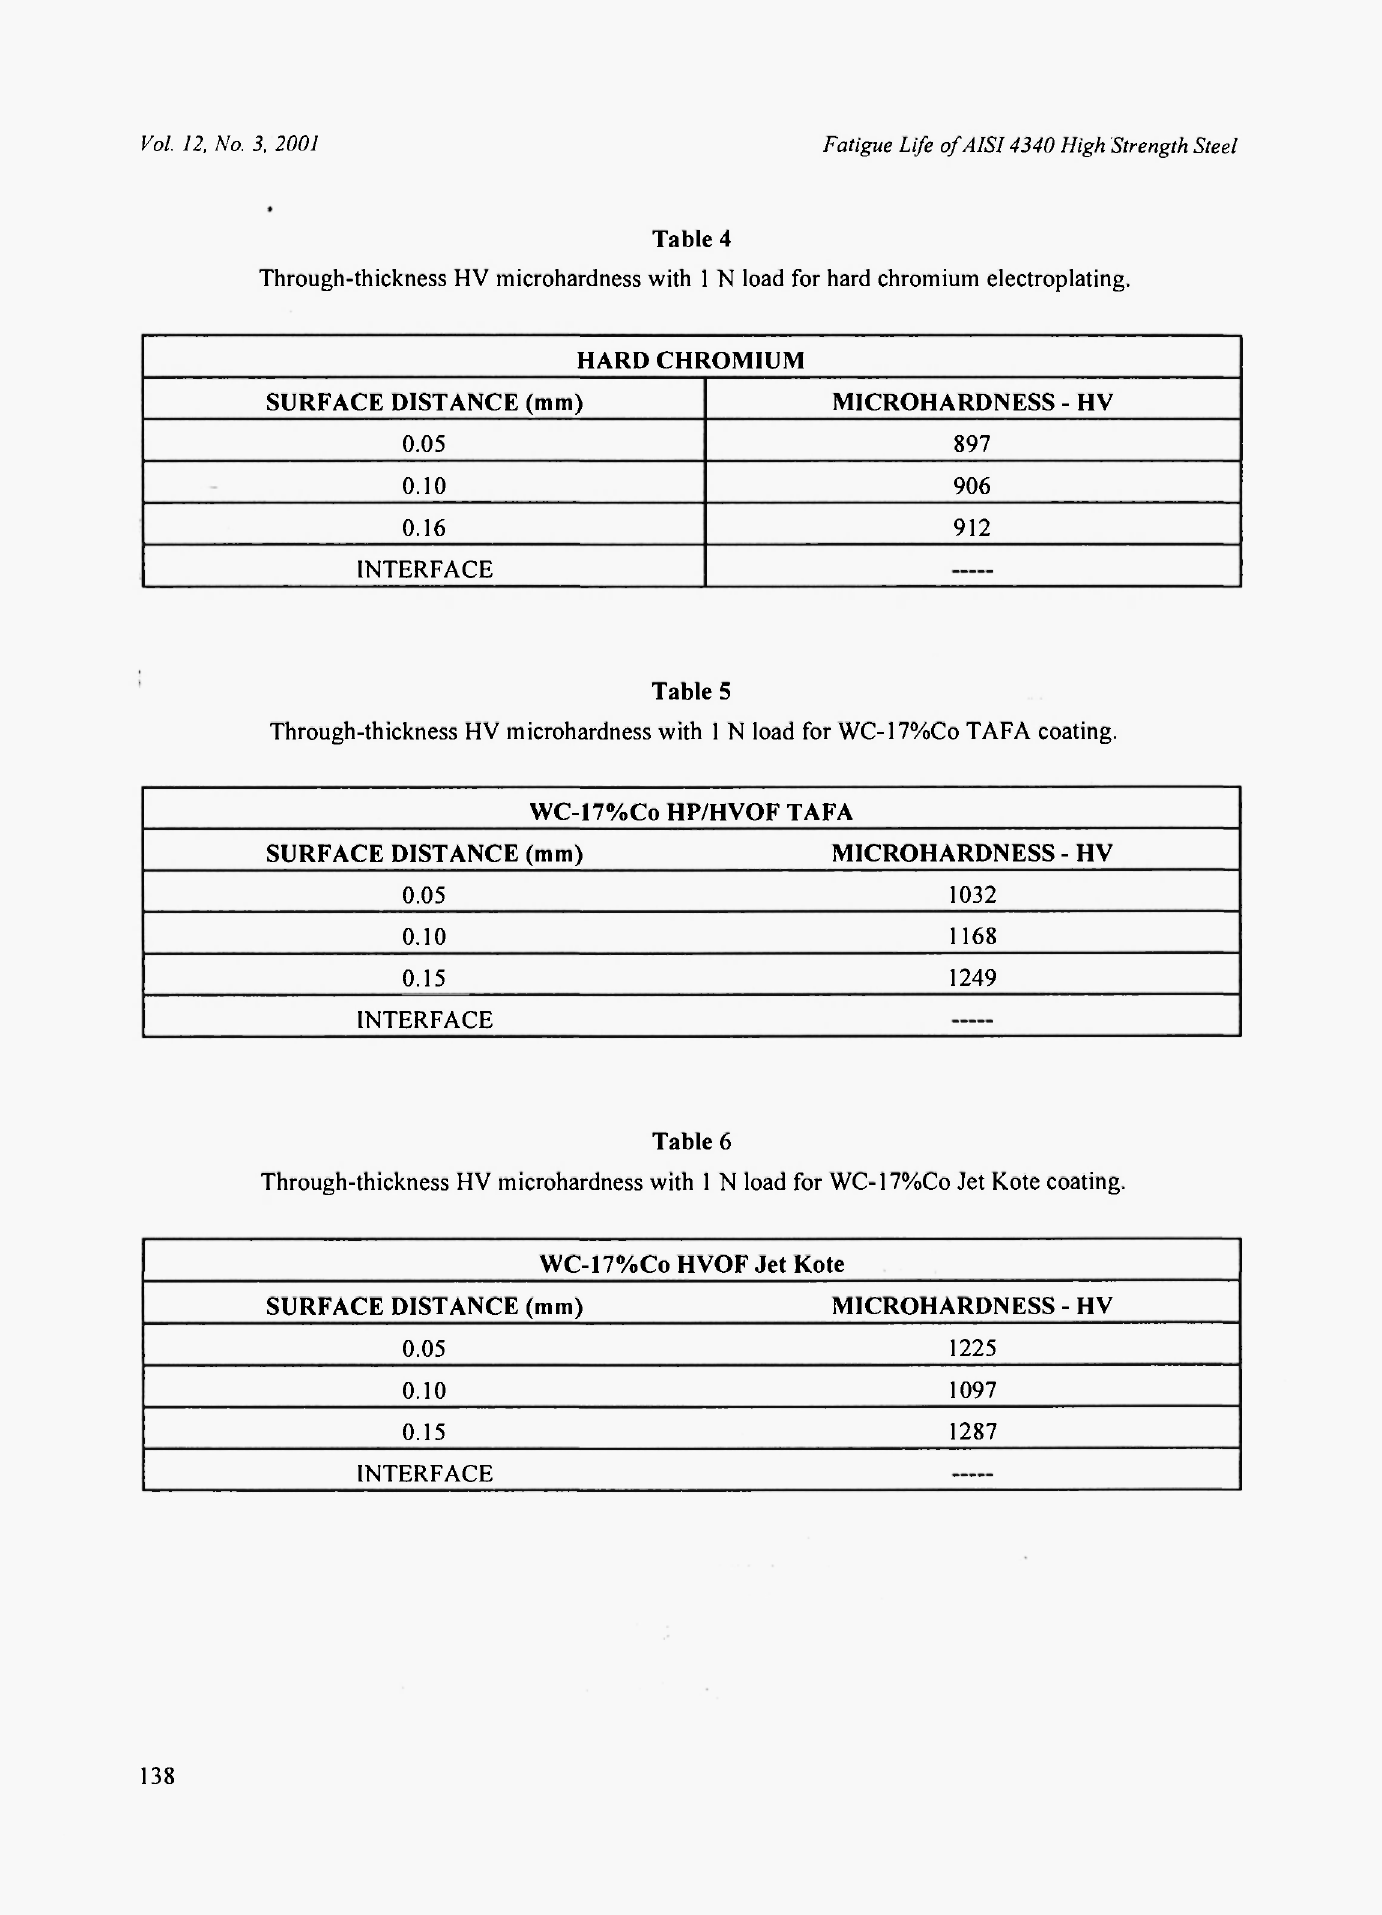
Through-thickness HV microhardness with 1 Ν load for hard chromium electroplating.